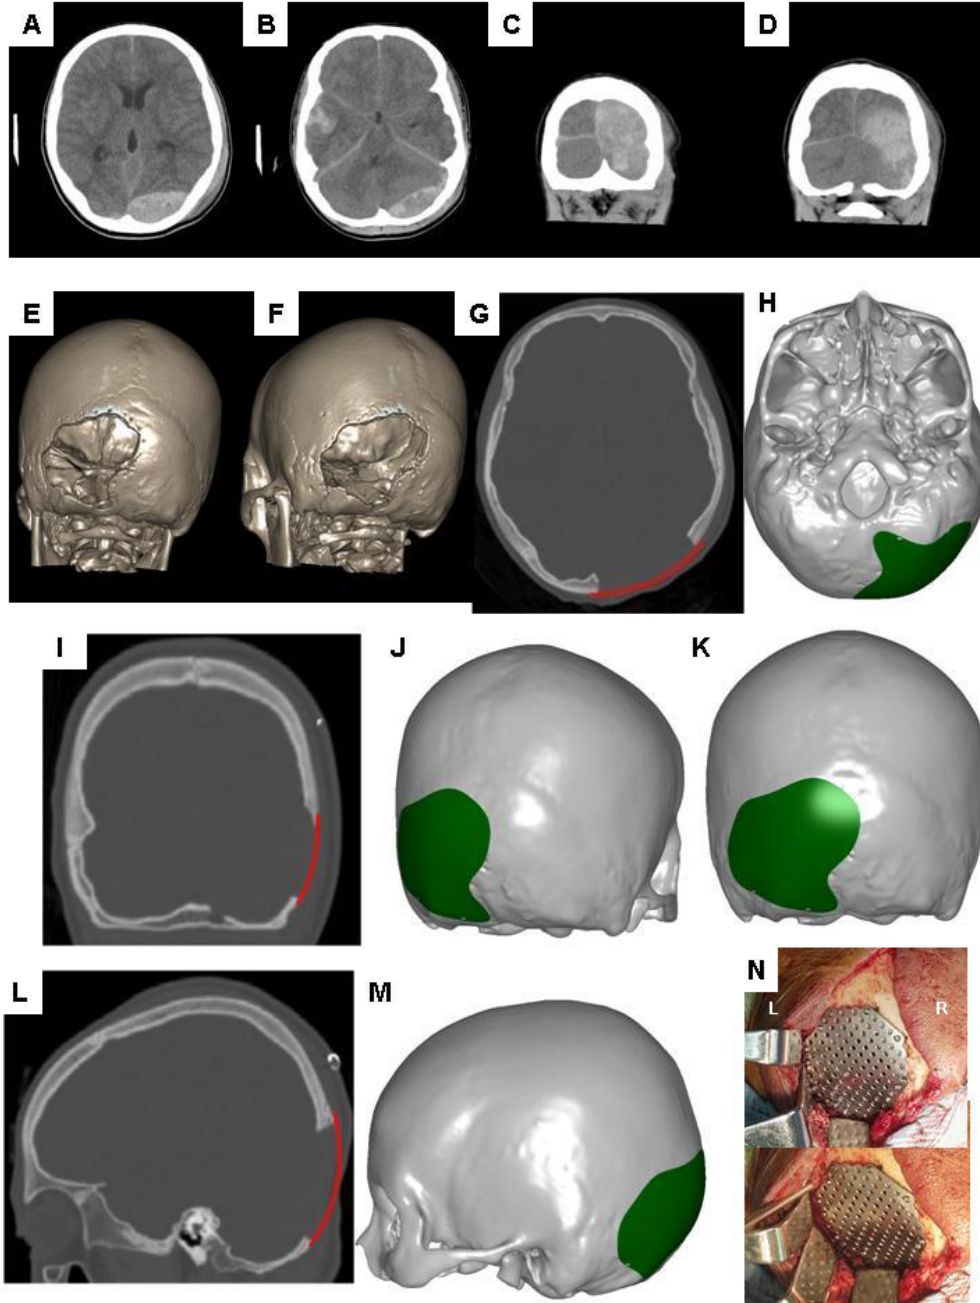
Figure 3. A 3-D CAD model for the skull defect reconstruction of case 2. Axial ( A , B ), and coronal ( C , D ) CT images showing supra- and infratentorial acute epidural hematoma with mass effect. ( E , F ) The 3-D CAD reconstructions demonstrating skull defects in the demonstrated case underwent decompressive craniectomy and removal of hematoma. After having a full recovery of consciousness, the patient received cranioplasty using a 3-D CAD/CAM-fabricated titanium mesh. The reconstructed contour of the skull defect, as labeled in red, axial view in ( G ), coronal view in ( I ), and sagittal view in ( L ). The reconstructed artificial flap was labeled in green, as shown in the axial view ( H ), coronal view ( J , K ), and sagittal view ( M ). ( N ) CAD/CAM titanium implants for the reconstruction of skull defects. The patient, fixed with the Mayfield skull clamp, was placed in a prone position during the operation. The skull defect was located at the left of posterior fossa. Note that the titanium implant smoothly follows the contour to the cranial curvature of posterior fossa. R: right; L: